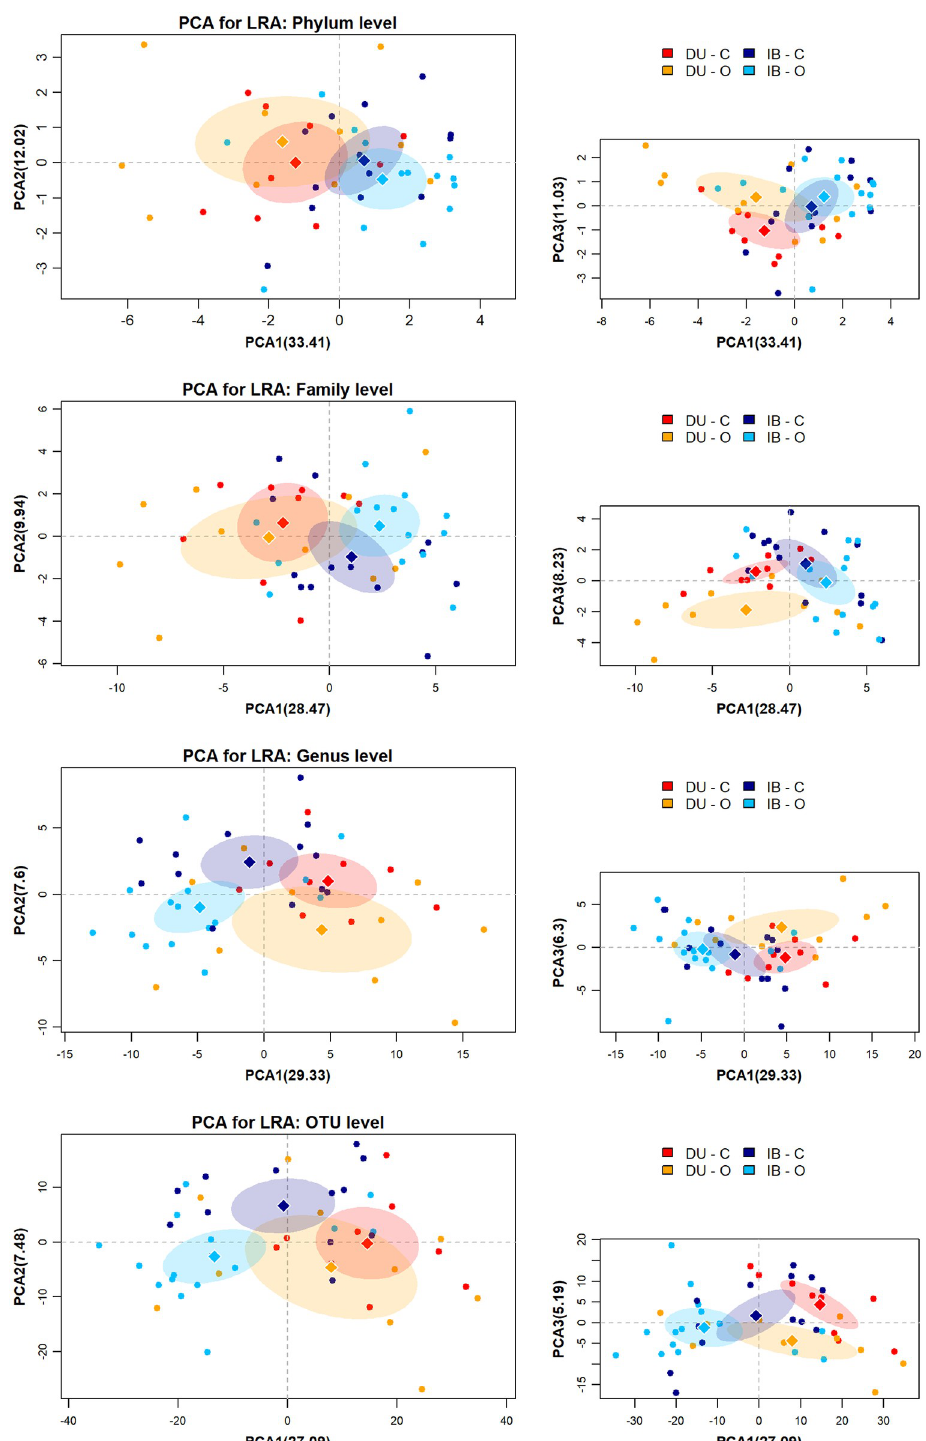
Fig 3. β -diversity plots. Beta-diversity plots from PCA of CLR-transformed data, at phylum, family, genus and OTU levels and variance percentage explained by each component. Ellipses show the Normal-theory confidence regions with alpha = 0.95. Centroids are represented by diamond-shaped